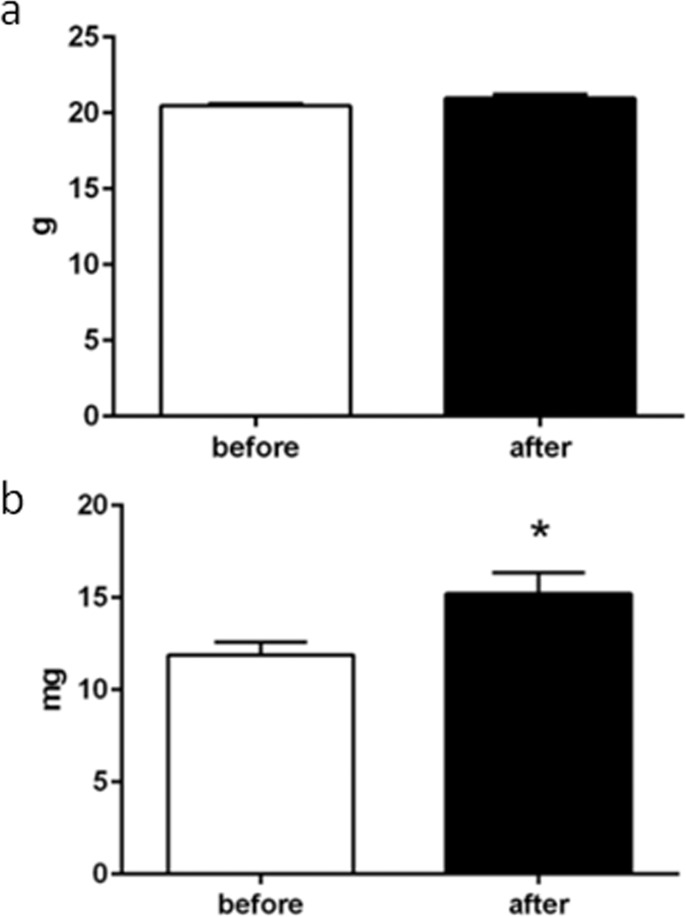
Biometric data of the mice and grafts.(a) There was no difference between host mice body weights (g) before and after xenotransplantation. However, (b) the graft weight (mg) 10 days after xenotransplantation was greater (P<0.01) than before.